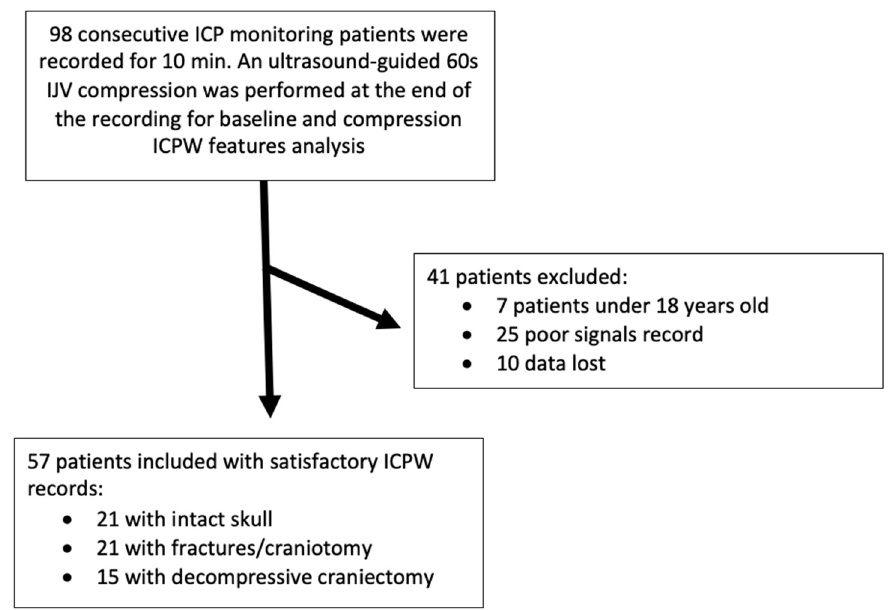
Figure 4. Flow chart with sample and procedure description. ICP: intracranial pressure, ICPW: intracranial pressure pulse waveform, IJV: internal jugular vein.